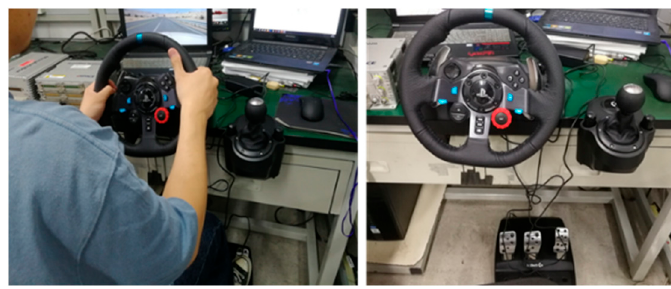
Figure 8. Driving Simulator. Table 1. Statistical results of extracted driving data for all